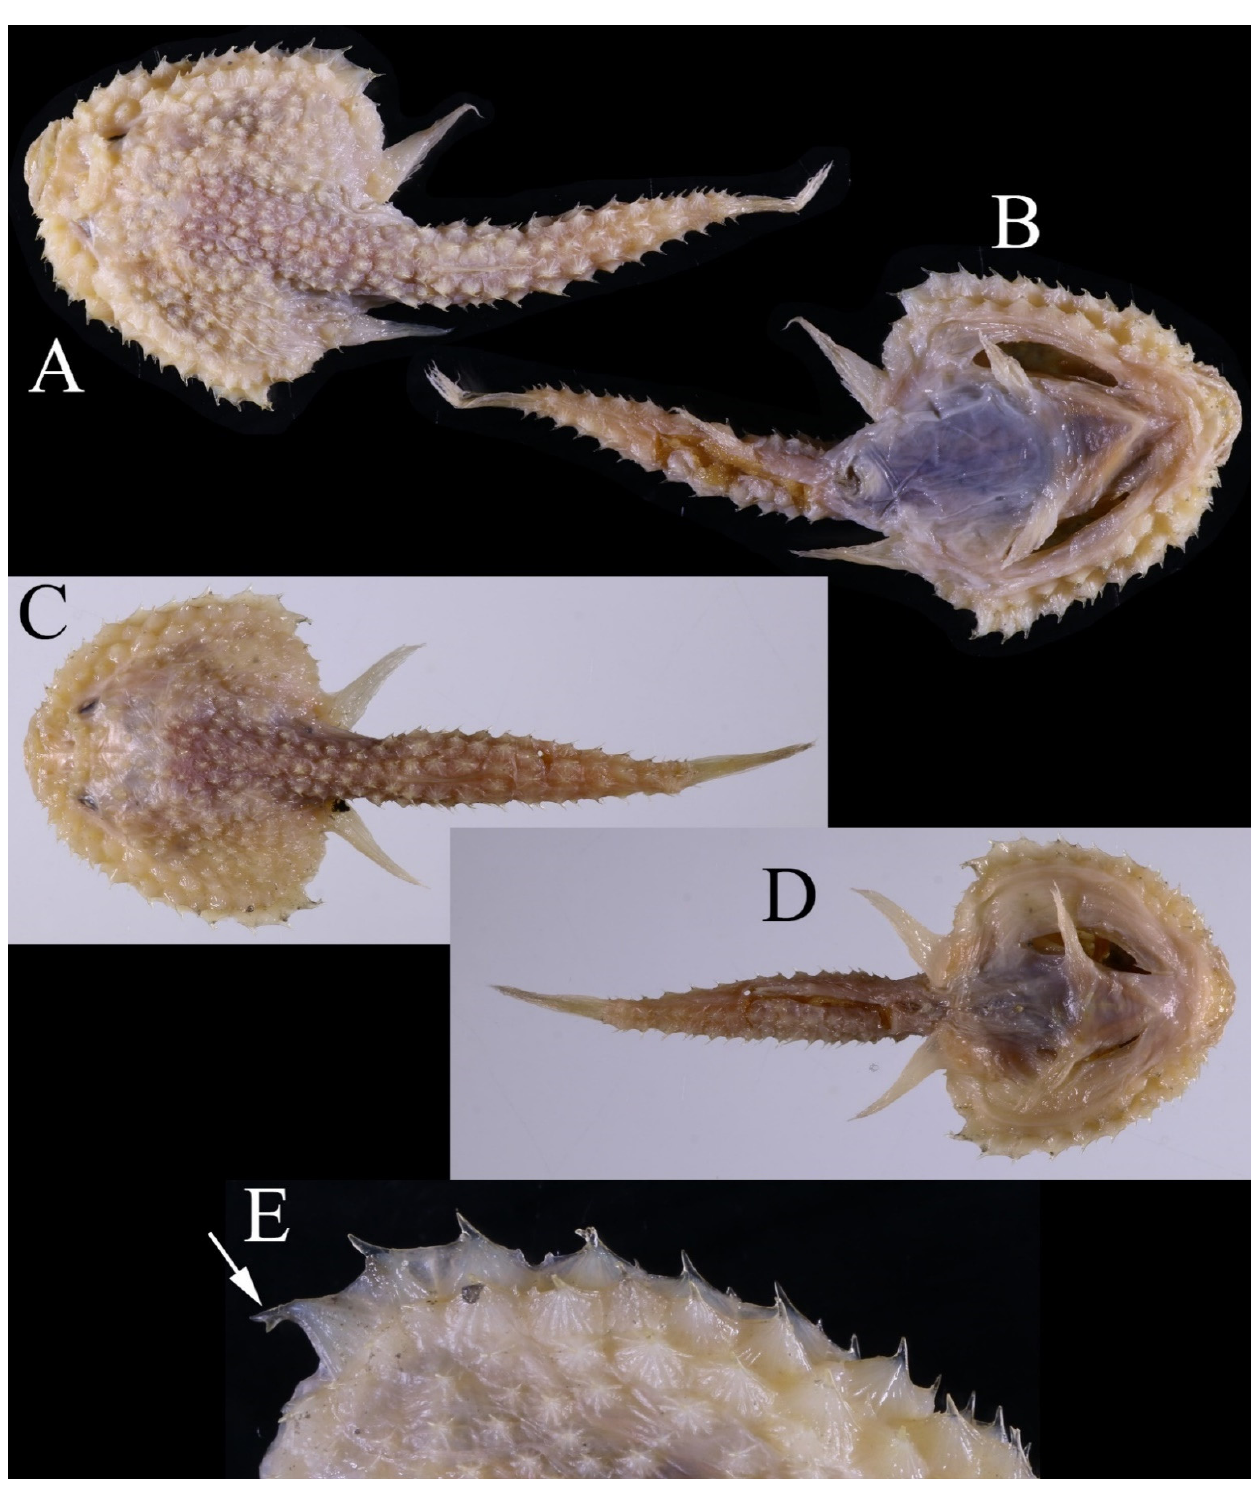
Figure 36. Halieutopsis taiwanea sp. nov., ( A , B ). Holotype, ASIZP 66325, 78.3 mm SL. ( C – E ). Paratype, ASIZP 63324, 70.1 mm